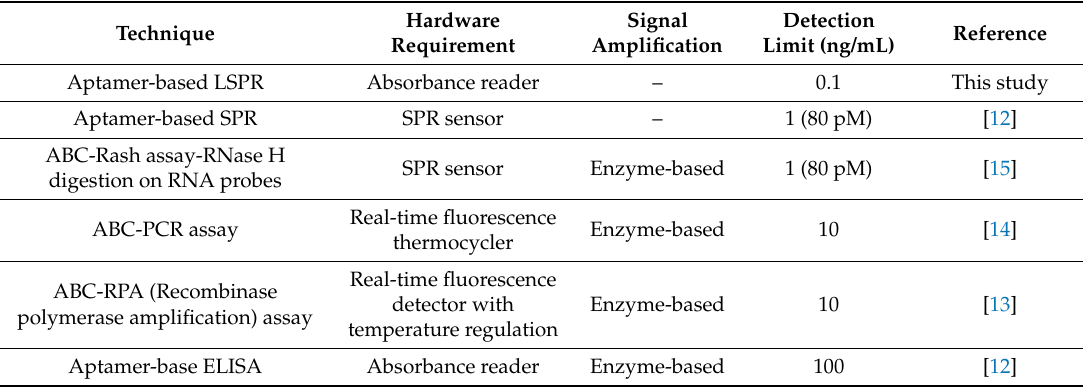
Table 1. Comparison of cyto- c sensing using aptamer via different